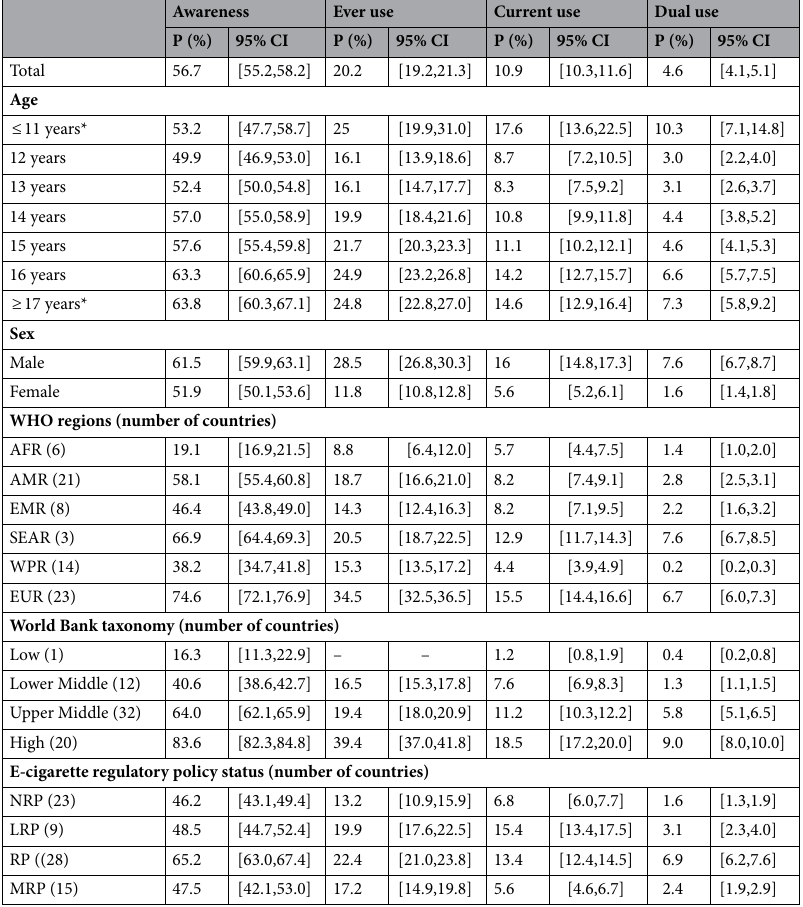
represent global prevalence or prevalence estimates for World Bank income groups and WHO regions. The number of countries in which GYTS included optional questions on e-cigarette use was smaller than the number of countries covered by GYTS. The question on e-cigarette use did not distinguish between electronic nicotine delivery systems (ENDS) and electronic non-nicotine delivery systems (ENNDS) 23 . Therefore, we were unable to provide estimates for these two types i.e. ENDS and ENNDS 29 . Our estimates for 2014 to 2019, are not very up-to-date because e-cigarette use patterns among youth are evolving rapidly due to aggressive marketing strate- gies by tobacco companies. Interpretation and comparison with related studies. Our findings are consistent with published reports that e-cigarette use varies across countries 8,17,21 , based on the different indicators used to define e-cig- arette use 22 . The cross national difference in e-cigarette use are due to the different regulatory frameworks for e-cigarettes 26,30 . The very high prevalence of awareness is consistent with studies from HIC in which exposure to e-cigarettes through online media 31,32 . or witnessing of e-cigarette use by youth among peers, family, or in public is common. A significant correlation between estimates of awareness and ever use of e-cigarette use supports the argument that increased awareness through aggressive advertising and marketing has led to experimentation with e-cigarette (to try them out) and subsequent regular use 33 . Higher rates of e-cigarette use in HIC may be attributed to higher disposable income among youth compared to their peers in uMIC or lMIC 34 . Higher pocket money among the youth led to higher odds of them being e-cigarette use in a European study 21 . Tobacco com- pany strategies such as advertising attractive flavors, sleek models, and online sales have increased e-cigarette use in HIC 21,35 however such data are lacking for uMIC and lMIC. The distribution of pooled estimates by WHO region is consistent with existing reports from the EUR and AMR 8,20,21,36 . Higher e-cigarette use rates among boys than girls, is comparable to sex difference reported about cigarette smoking 37 . The ratio of boys to girls for cigarette smoking > 1 is consistent with the existing literature 7,37 . In most